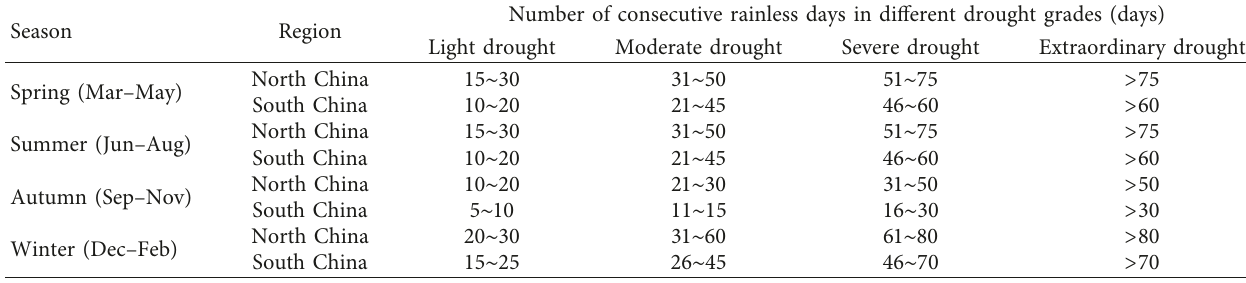
Table 6: Consecutive rainless days: drought grade standards.